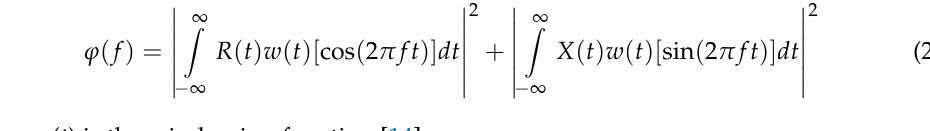
Figure 2. Schematic of electrode-tissue impedance (ETI) measurement.